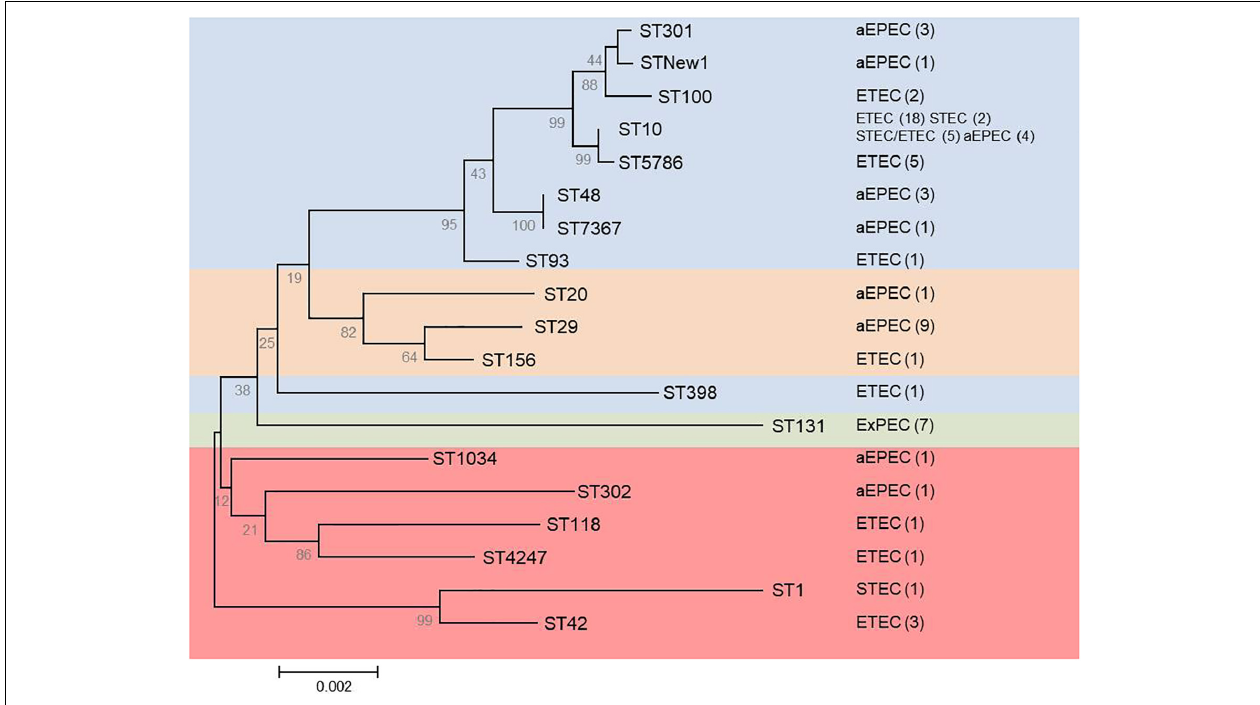
FIGURE 1 | Phylogenetic tree based on concatenated sequences of the seven housekeeping genes from the MLST Achtman scheme by the neighbor-joining method using MEGA6. The analysis includes the 19 STs determined for the mcr-1 (65 diarrheagenic and seven ST131-B2) positive isolates. Numbers on the tree indicate bootstrap values calculated for 1,000 replicates. Colors indicate: blue (phylogroup A), orange (phylogroup B1), green (phylogroup B2), and red (phylogroup E). Pathotype and number of isolates (in parentheses) are shown on the